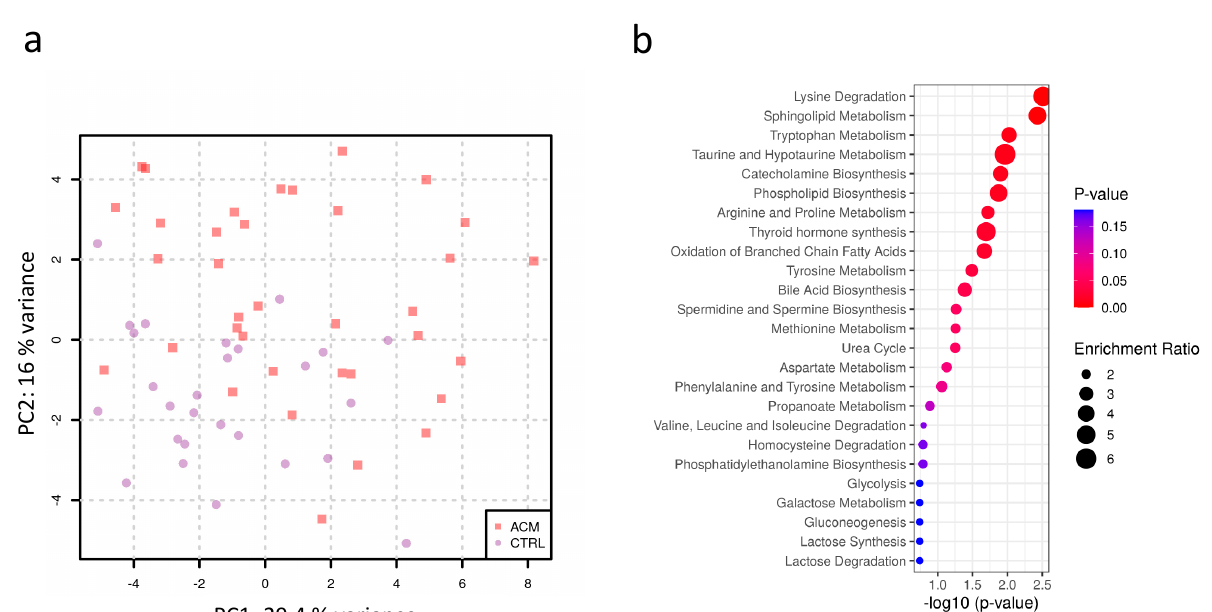
Table 2. List of the significant metabolites and ratios. The table shows the analyte name, the log2 fold change and the p -value adjusted for multiple hypothesis testing. Analytes were sorted by the difference in abundance.